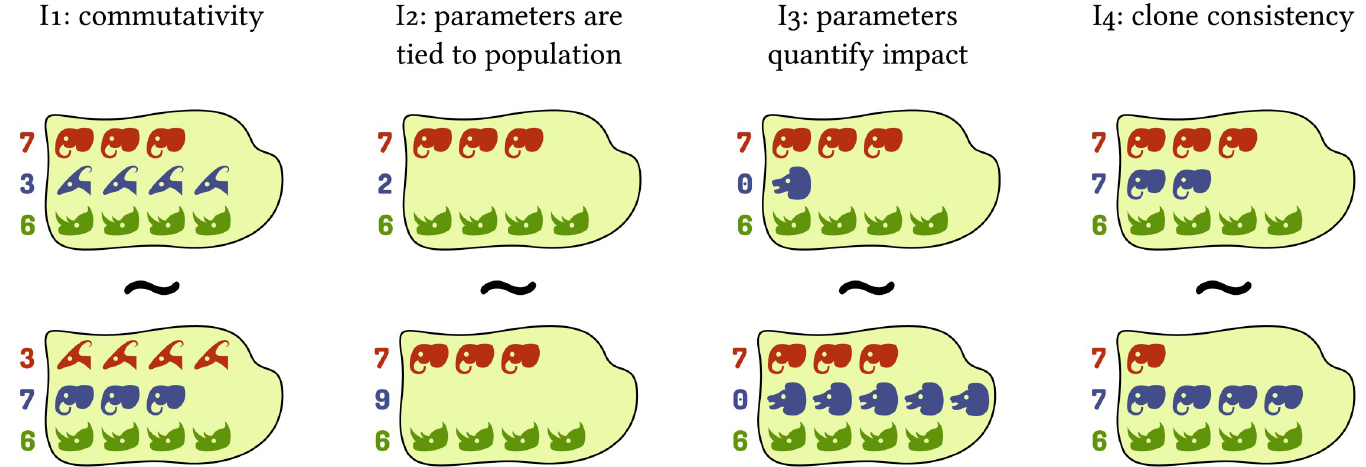
Fig 2. Criteria for impact functions exemplified for the grazing impact of animal populations. Each island represents a community. Each row and color represents one population in the model, with animal heads representing individuals. Numbers on the left represent parameters governing the respective population (grazing rate in the example), and head shapes indicate whether populations have identical properties as per these parameters. The similar sign ( � ) indicates that two communities are equivalent as arguments of an impact function, i.e., they should yield the same result (total amount of grazing in the example).